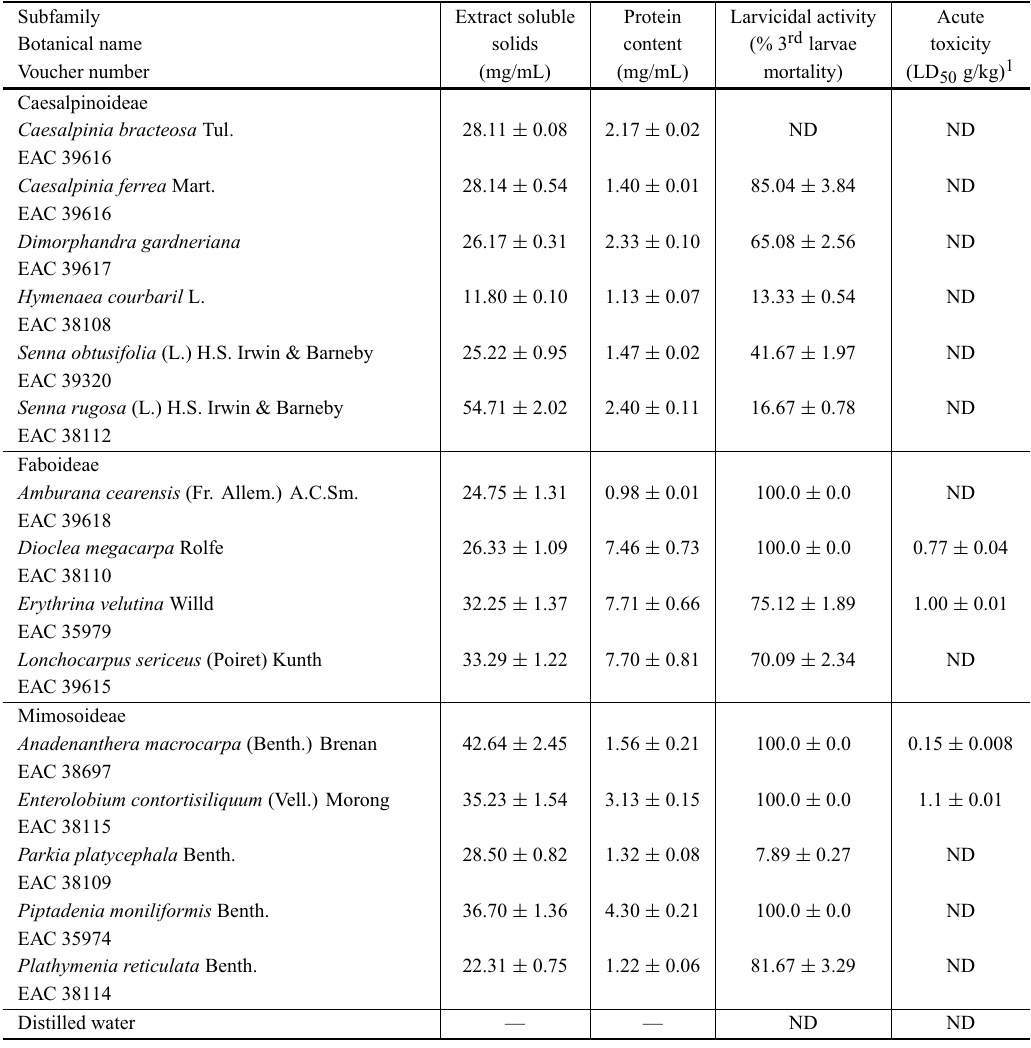
Leguminous species (Fabaceae) employed in this study, soluble solids concentration, protein content and toxic activities of seeds water extract against Aedes aegypti larvae and